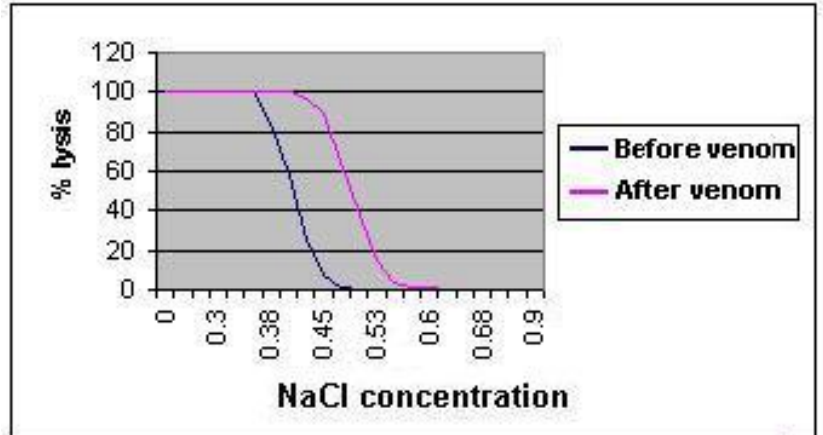
Figure 2. In vivo osmotic fragility of rabbits’ red blood cells incubated at increasing concentrations of NaCl before and after H. lepturus venom